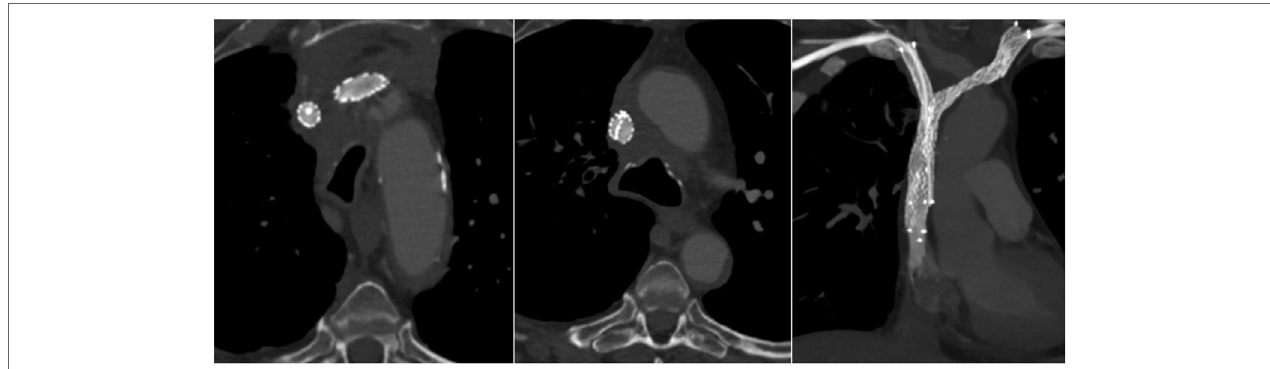
FIgURe 4 | A 3-month follow-up computed tomography (axial sections and coronal section in maximum intensity projection) demonstrated bilateral stents patency without collateral veins. The left-sided stent, which ensures head and neck venous drainage, had a larger expansion than the right-sided